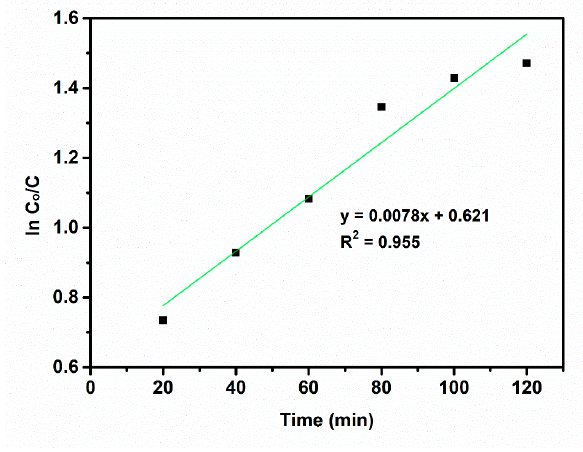
Figure 10. Langmuir–Hinshelwood kinetic model for CIP degradation using CBB photocatalyst un- der direct sunlight. under direct sunlight.